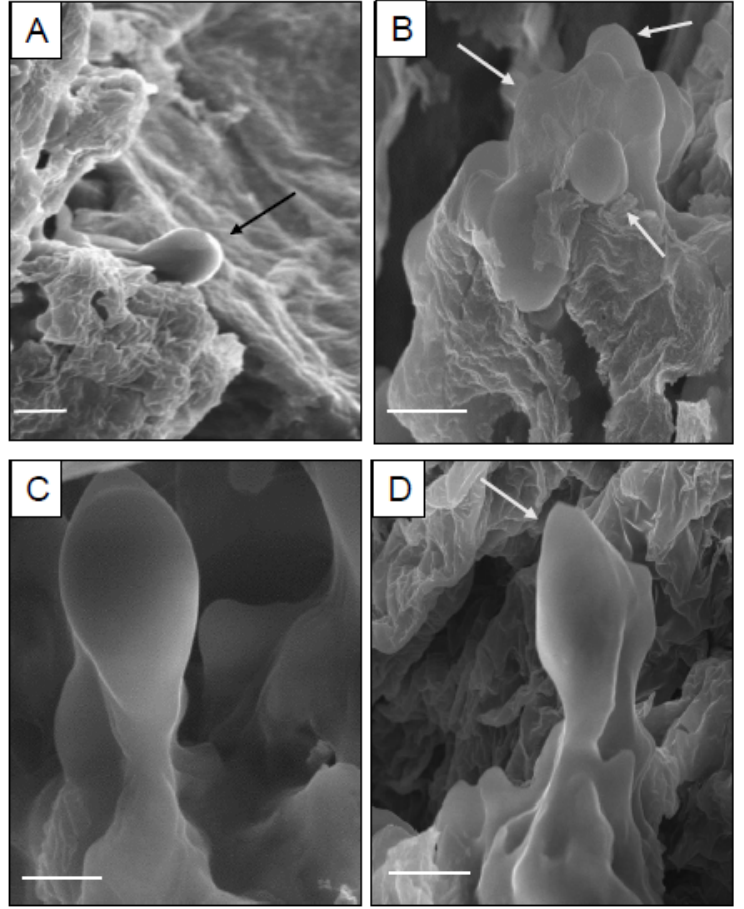
Figure 5. Scanning electron microscopic (SEM) images of somatic embryos in D. purpurea . ( A ) Globular shaped somatic embryo (bar = 20 µ m), ( B ) Cluster of globular shaped somatic embryos (bar = 2 µ m), ( C ) Globular shaped embryo with suspensor (bar = 2 µ m), ( D ) Heart shaped somatic embryo (bar = 2 µ m).